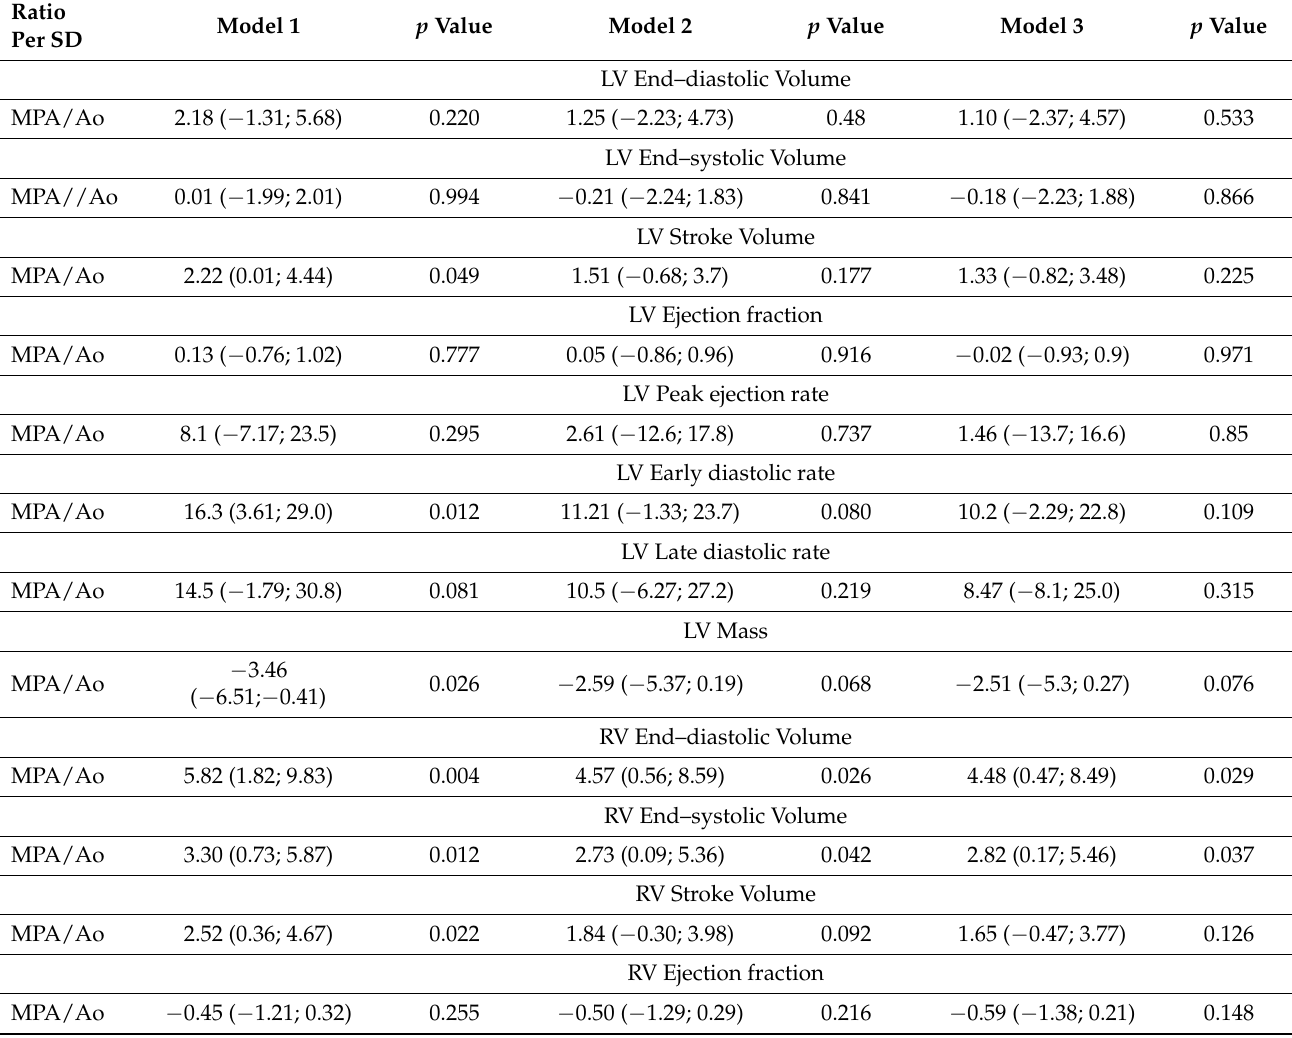
Table 4. Association between Ratio of MPA/Ao and ventricle